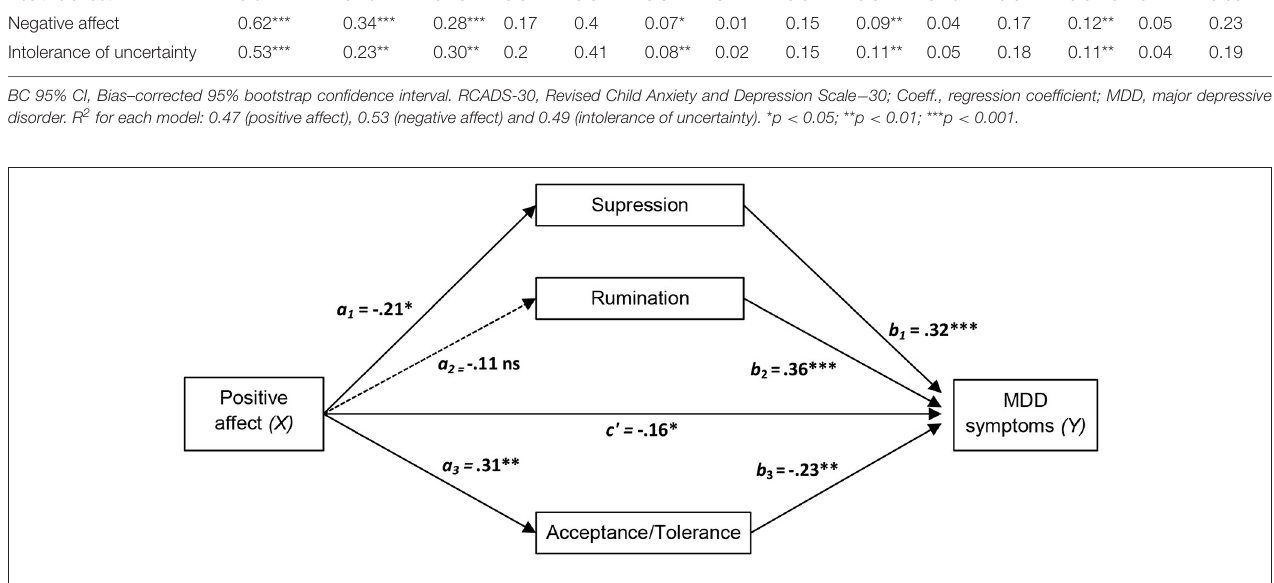
FIGURE 1 | Diagram of the parallel multiple mediator model for the direct and indirect effects of positive affect on major depressive disorder (MDD) symptoms via emotion regulation strategies (acceptance/tolerance, suppression, and rumination). Fully standardized regression coefficients are shown. See Table 5 for indirect and total effect coefficients. a , effect of X on a mediator; b , effect of the mediator on Y ; c ′ , direct effect of X on Y . * p < 0.05; ** p < 0.01; *** p <